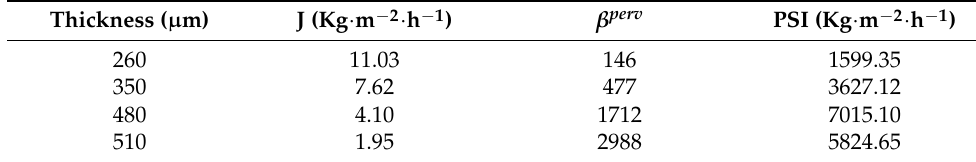
Table 9. Pervaporative parameters of a SILICONE1200 membrane obtained during 1.5 h of separation at 20 ◦ C with a stirring rate of 250 rpm using different membrane thicknesses.